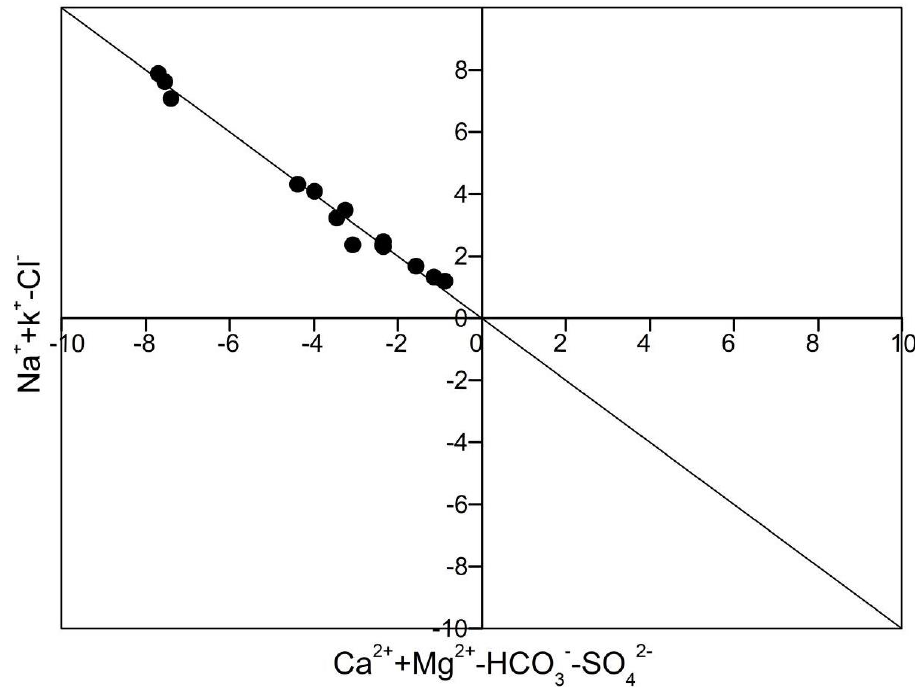
Figure 9. Relationship between Ca 2+ +Mg 2+ -HCO 3 − -SO 42- and Na + + K + -Cl − ions of phreatic aquifer in Yongqing County.